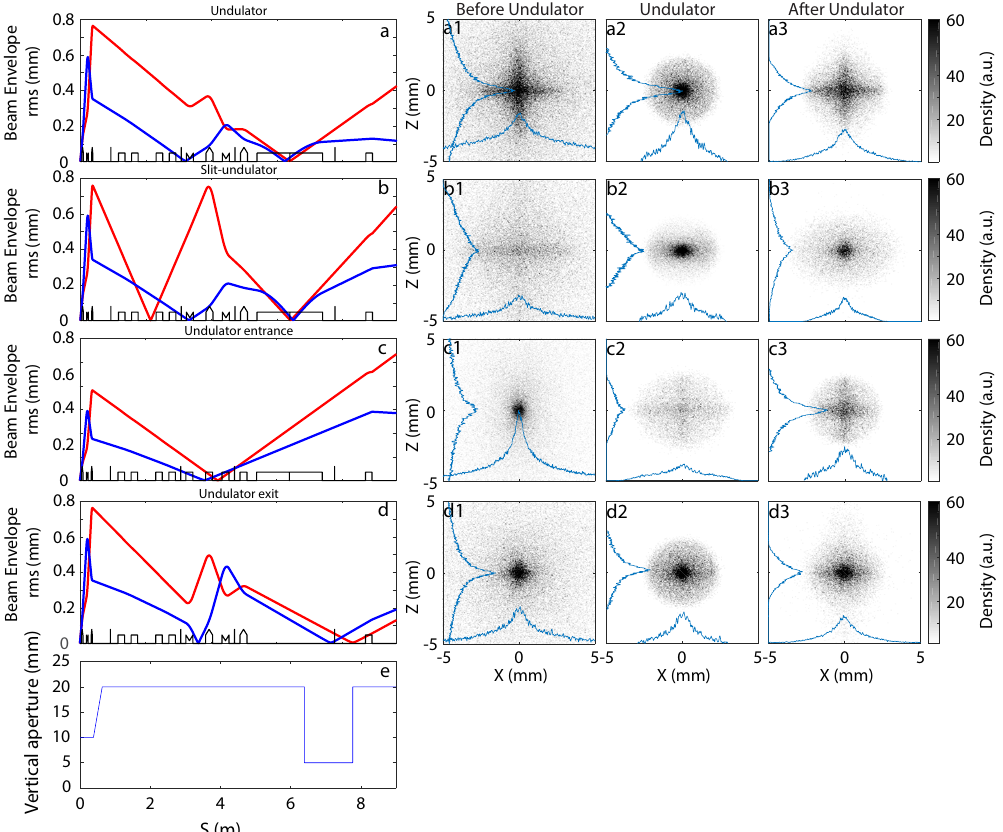
Figure 5. Simulation of the horizontal ( red ) and vertical ( blue ) (relative energy spread (RMS)) beam envelope of the optics ( a ) “undulator”, ( b ) “slit-undulator”, ( c ) “undulator-entrance”, and ( d ) “undulator-exit” along the line for a flat-top energy spectrum beam of 176 ± 0.3 MeV, = 2 mrad RMS and σ (cid:48) = 3.12 mrad RMS. Transversal distribution of the electron beam with σ (cid:48) z , i x , i at the undulator entrance ( a1 – d1 ), center ( a2 – d2 ), and exit ( a3 – d3 ) for the low divergence beam case (parameters of Figure 2a and Table 1) associated with the corresponding magnetic elements settings given in Table 3. Transport line elements representation ( black ) with screens ( vertical line ), dipoles ( rectangle ), and focusing ( rectangle with indentation ) and defocusing quadrupoles ( triangle on top ). ( e ) Vertical aperture along the longitudinal direction of the transport